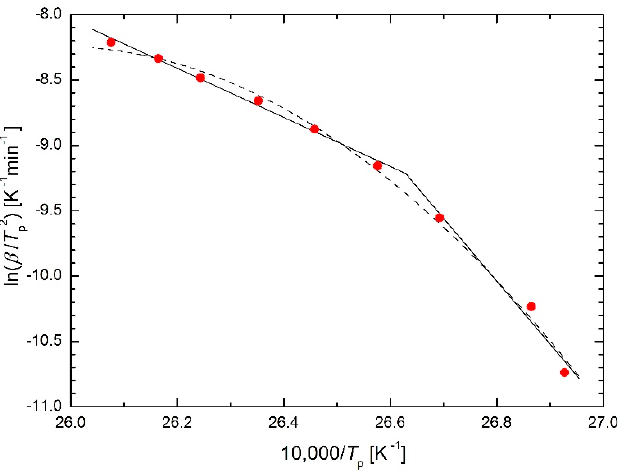
Figure 1. “Double” Kissinger plot for Ni-Mn-In-Mg shape memory alloy (see [5], Figure 7, solid line) and Kissinger plot based on the analogy of the Equation (5) (dashed line). and Kissinger plot based on the analogy of the Equation (5) (dashed